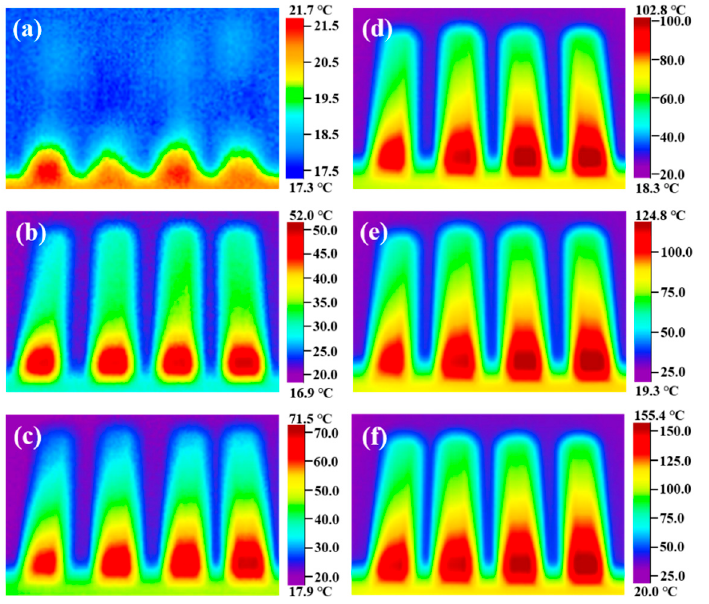
Figure 9. Infrared thermography images of samples S 0 , S 2 , S 4 , and S 6 heated on the heating plate for different times: ( a ) 0 s, ( b ) 60 s, ( c ) 120 s, ( d ) 180 s, ( e ) 240 s, and ( f ) 300 s.